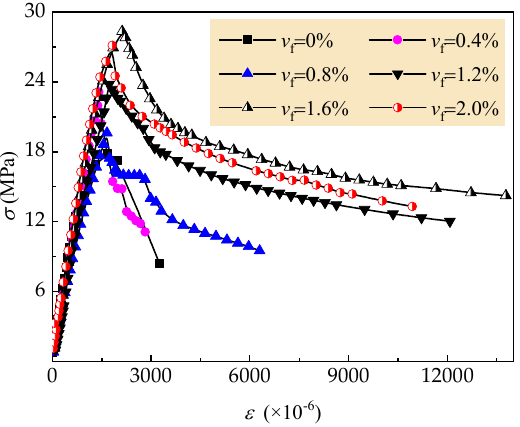
Figure 10. Stress-strain curves of tested self-compacting SFRELC with different v f.